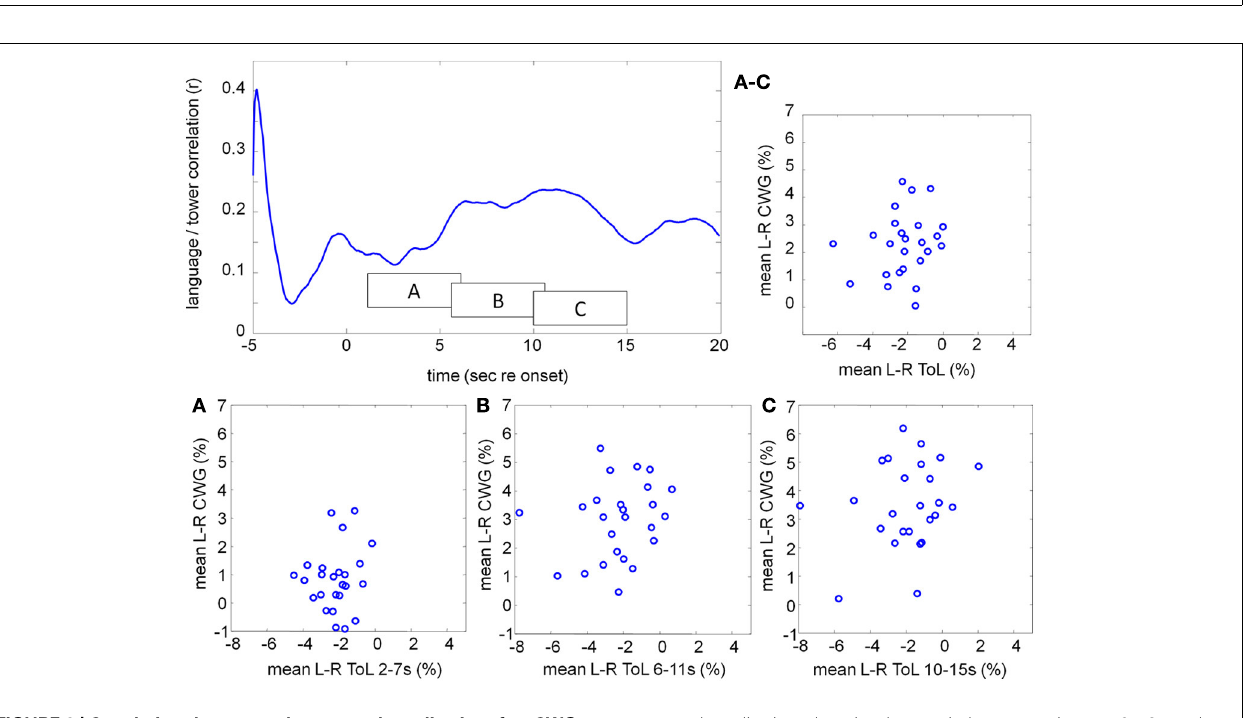
average lateralization data in three windows, starting at 2, 6, and 10s after task onset are shown in boxes A, B, C. The average lateralization for each subject between 2 and 15s re task onset is shown on the top right ( labeled A–C)